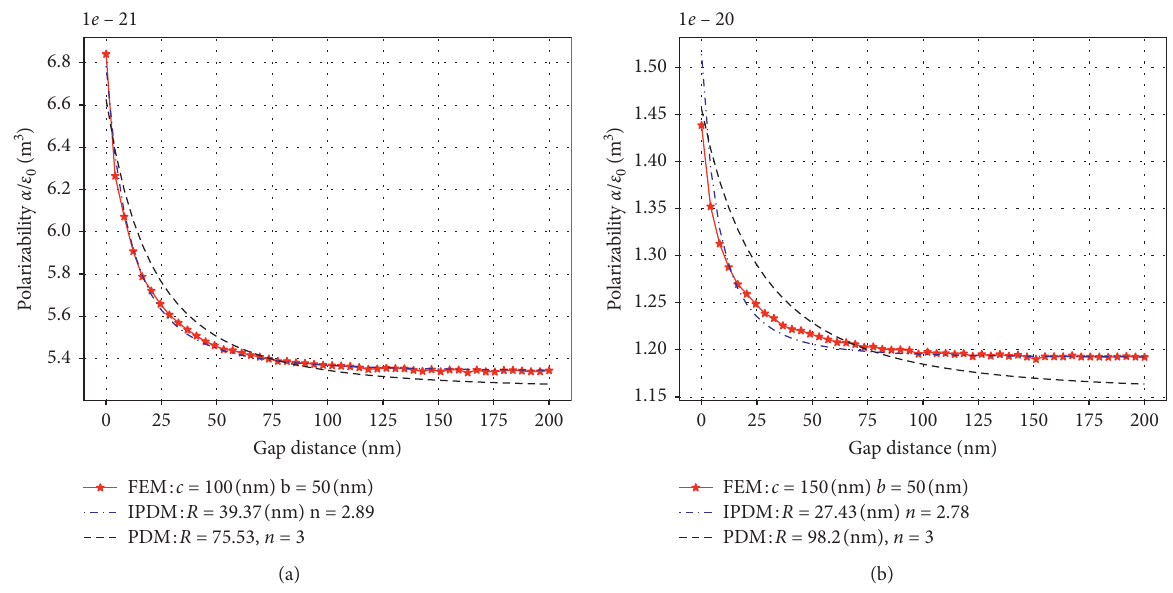
Figure 5: (a) The probe-approaching curve for case 1. The dielectric constant of the dielectric ellipsoid is 100, the semiminor axis is 50nm, and the semimajor axis is 100nm. Equivalent metal sphere radius is 47.08nm, and distance change index n � 3.36. (b) The probe- approaching curve for case 2. The dielectric constant of the dielectric ellipsoid is 100, the semiminor axis is 50nm, and the semimajor axis is 150nm. Equivalent metal sphere radius is 27.43nm, distance change index n � 2.78.